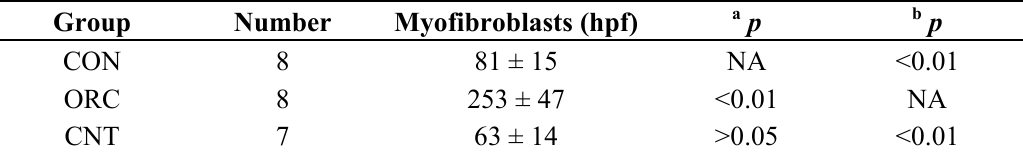
Table 1. Myofibroblast counts in the CON, ORC and CNT